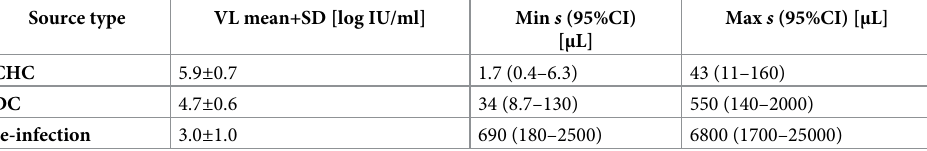
Table 3. Projecting the necessary saline bottle contamination level based on individual’s